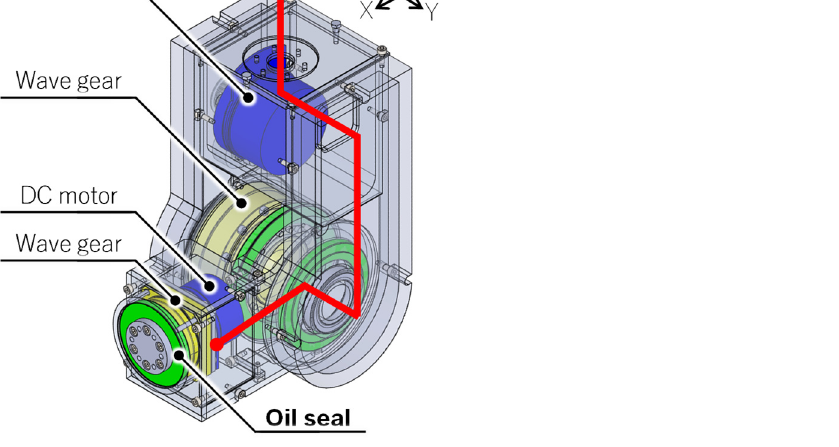
Figure 7. Pitch and roll joints mechanism. Red line means wiring in the body.